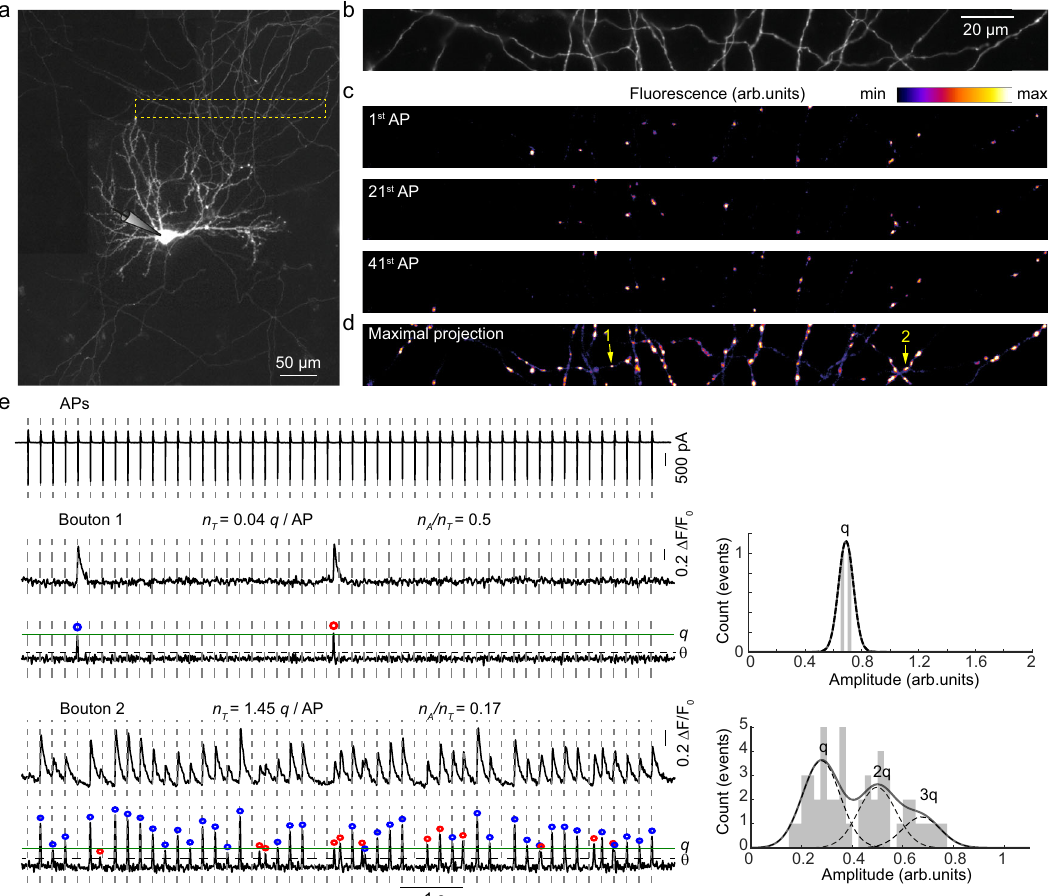
Fig. 1 SF-iGluSnFR fl uorescence imaging of quantal synchronous and asynchronous release in tens of individual presynaptic boutons supplied by a single axon. A detailed illustration of the experimental paradigm in a representative wild-type neuron (total N = 16 neurons from 5 culture preparations were recorded). a Reconstructed mosaic image of a pyramidal neuron expressing the SF-iGluSnFR probe. b A region of interest (ROI) in the axonal arbour selected for imaging of presynaptic SF-iGluSnFR responses, corresponding to the yellow box in ( a ). c Heat maps of SF-iGluSnFR responses to the 1st, 21st, and 41st action potentials (APs) during a 5 Hz train of 51 action potentials. The images are averages of 3 frames from a band-pass fi ltered image stack immediately after each action potential (see Methods and Supplementary Movie 1). d Maximal projection of the band-pass fi ltered image stack, revealing locations of all presynaptic boutons that released at least one vesicle during the stimulation train. e Analysis of quantal SF-iGluSnFR responses in two representative boutons (Boutons 1 and 2 in d ). Left, somatic action potential escape currents time-aligned with band-pass fi ltered and deconvolved SF- iGluSnFR signals. Quantal release events were identi fi ed as local maxima on the deconvolved traces located above the threshold θ (horizontal dashed lines) corresponding to 4 standard deviations of the background noise (see also Supplementary Figs. 2 – 6 and Methods). Blue circles mark synchronous and red circles mark asynchronous release events (see Fig. 2 for the de fi nition of the synchronous/asynchronous release time threshold). Right, quantal analysis. To determine the amplitude of SF-iGluSnFR signal corresponding to release of a single vesicle ( q , green lines on deconvolved traces) the positions of peaks on the amplitude histograms were fi tted with a sum of 4 Gaussian functions (black lines) (Methods). This was then used to calculate in each bouton the total number of vesicles released per action potential (release ef fi cacy n T ) and the fraction of asynchronous release events ( n A / n T ) (see Supplementary Figs. 5 and 6 for more